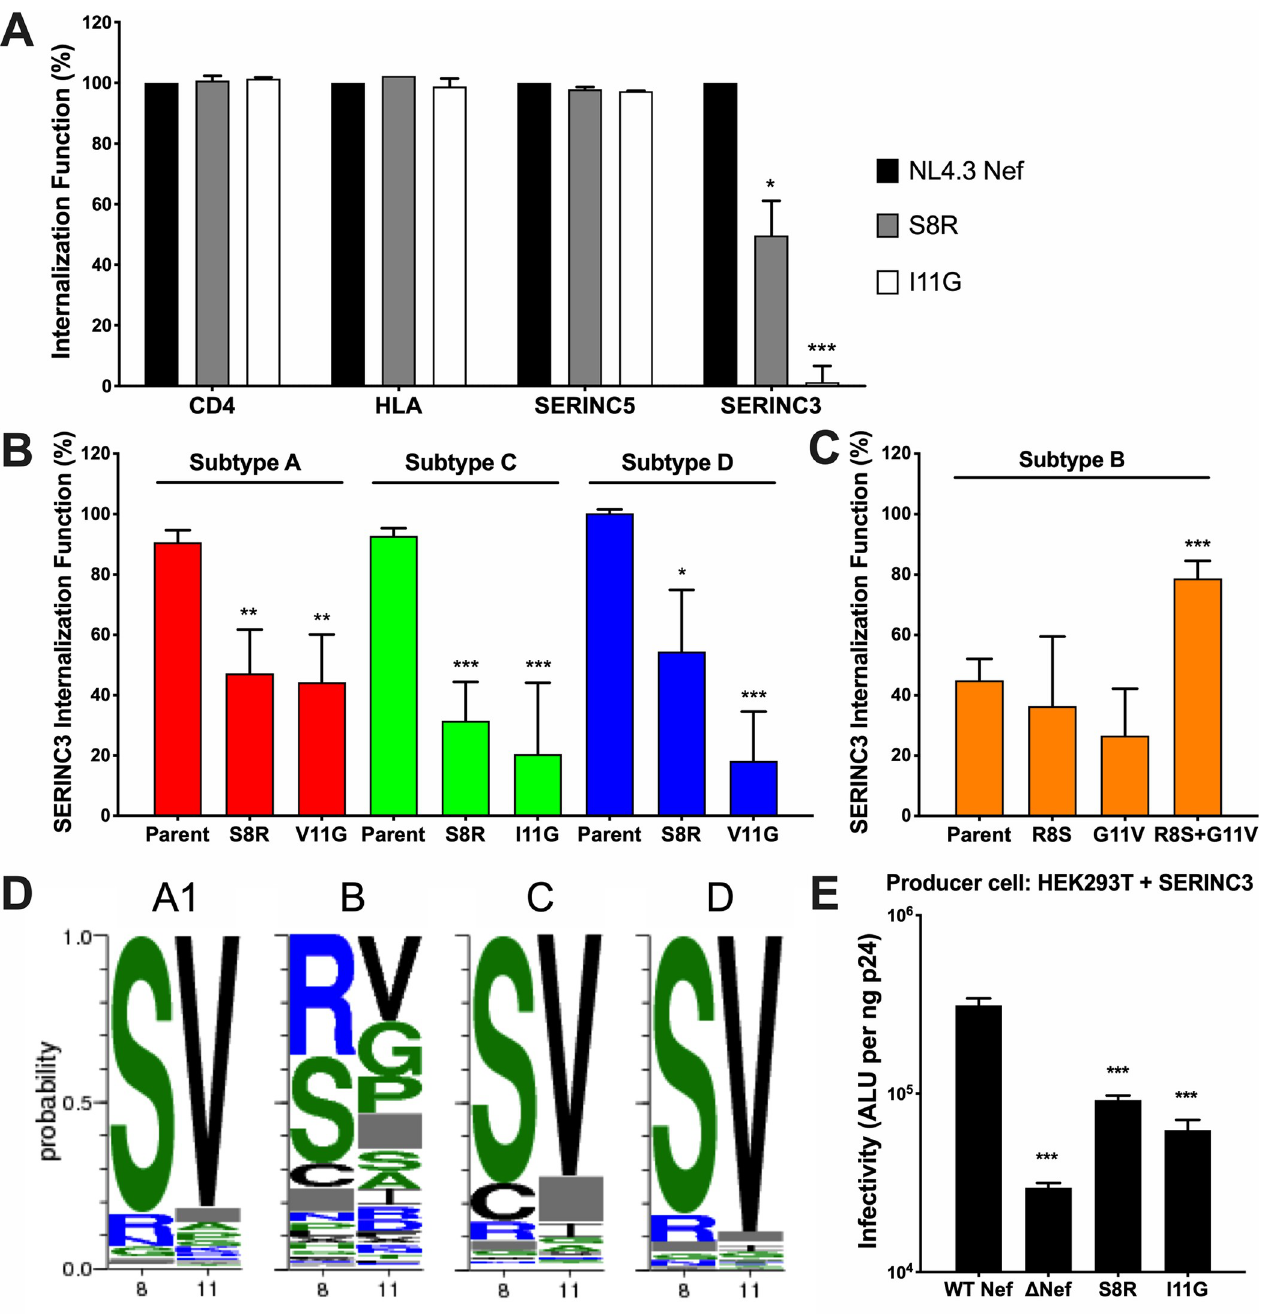
Fig 4. Polymorphisms at Nef residues 8 and 11 selectively impair SERINC3 internalization function. (A) The relative abilities of NL4.3 Nef mutants S8R and I11G to internalize CD4, HLA class I, SERINC5 and SERINC3 are shown. Results are normalized to wild type NL4.3 Nef (100%). Internalization function was assessed by flow cytometry following transfection of CEM T cells as described in the Methods. (B) The relative abilities of representative Nef clones from subtype A (red), subtype C (green) and subtype D (blue) and their respective mutants at positions 8 and 11 to internalize SERINC3 are displayed. (C) The relative abilities of a representative participant-derived subtype B Nef clone and its respective reversion mutations at positions 8 and 11 to internalize SERINC3 are shown. (D) Amino acid frequencies at Nef codons 8 and 11, based on 3775 Nef sequences representing HIV-1 subtypes A, B, C and D obtained from the Los Alamos National Labs HIV sequence database, are shown. (E) The relative infectivities of NL4.3-derived viruses encoding S8R or I11G mutations produced in the presence of SERINC3 are shown. Statistical analyses were conducted using the unpaired Students T test. Significant differences compared to Nef controls are indicated by asterisks ( � = p < 0.05; �� = p < 0.01; ��� = p < 0.001).